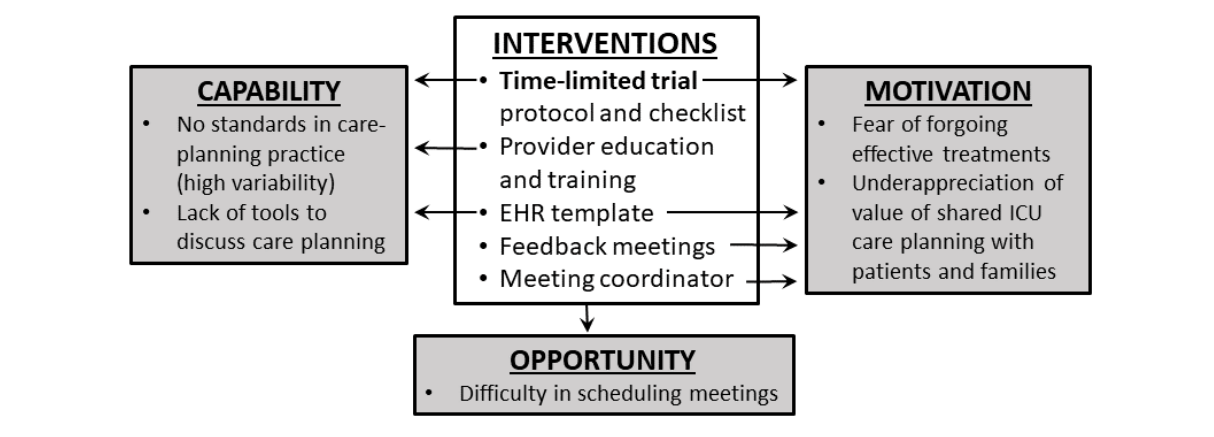
Figure 2. Conceptual framework for interventions. EHR: electronic health record; ICU: intensive care